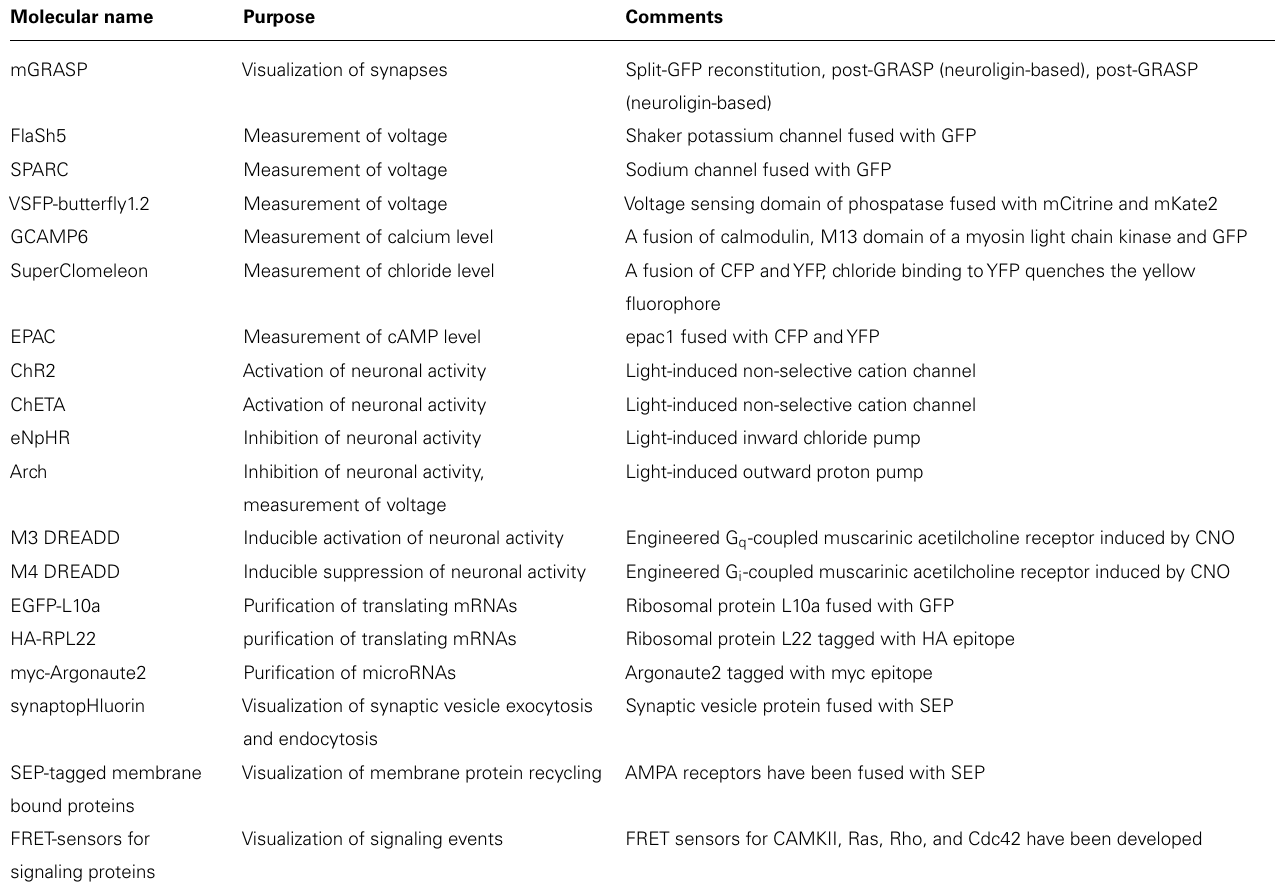
Table 1 | Genetically encoded molecular tools for visualizing, measuring and manipulating neural